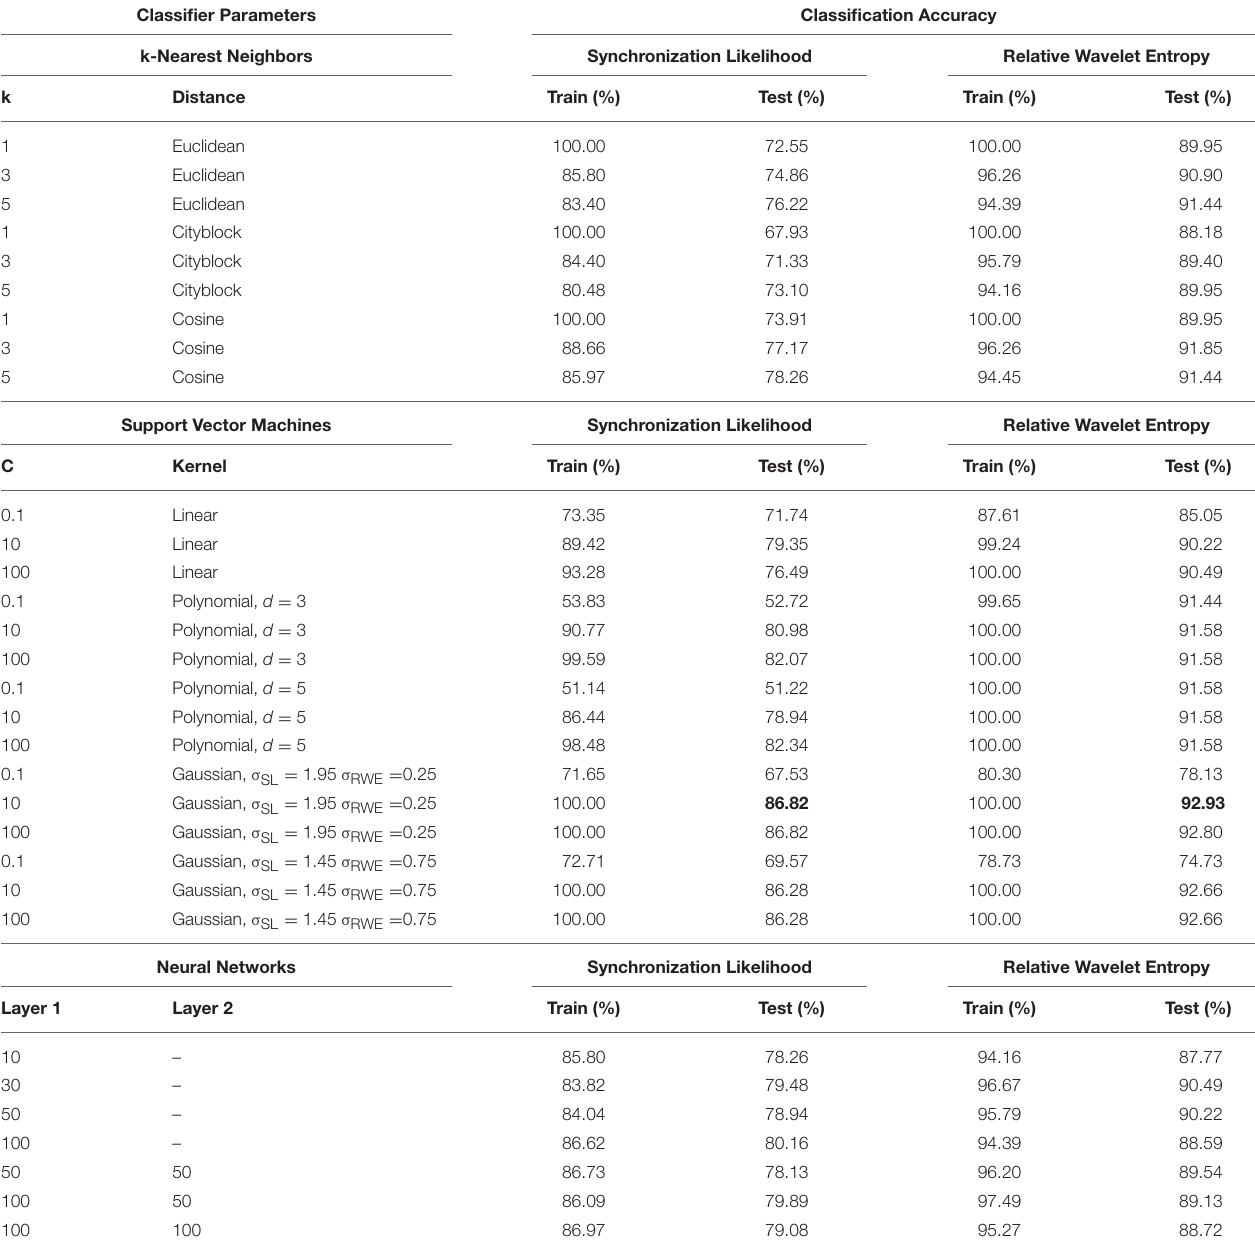
TABLE 2 | Sleep stage classification